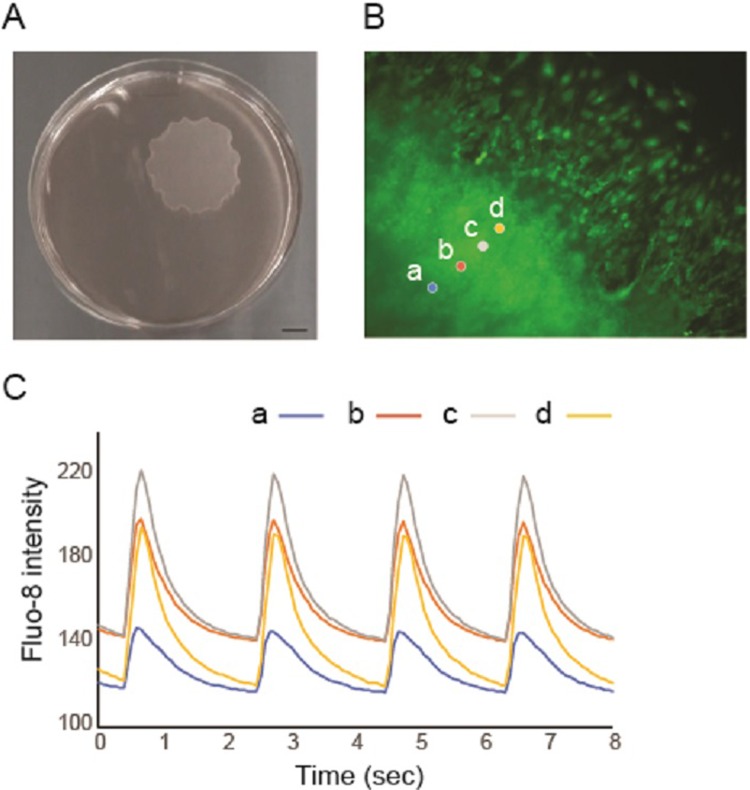
Generation of large cardiac tissue sheets (L-CTSs).(A) Optimal view of the L-CTS placed in a 10cm-sized UpCell dish. Scale bar = 1 mm. (B) (C) Calcium transient of L-CTSs. (B) Representative Fluo-8 image of L-CTS (see also S1 video) and region of interests (ROIs). Magnification ×100. (C) Chronologic intensity change of Fluo-8. Note that the peak timings of 4 different ROIs are almost same chronologically.